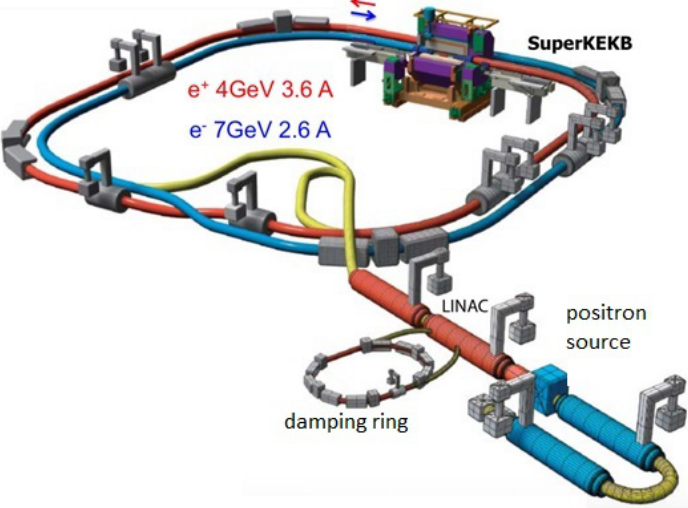
Figure 1. Schematic view of the